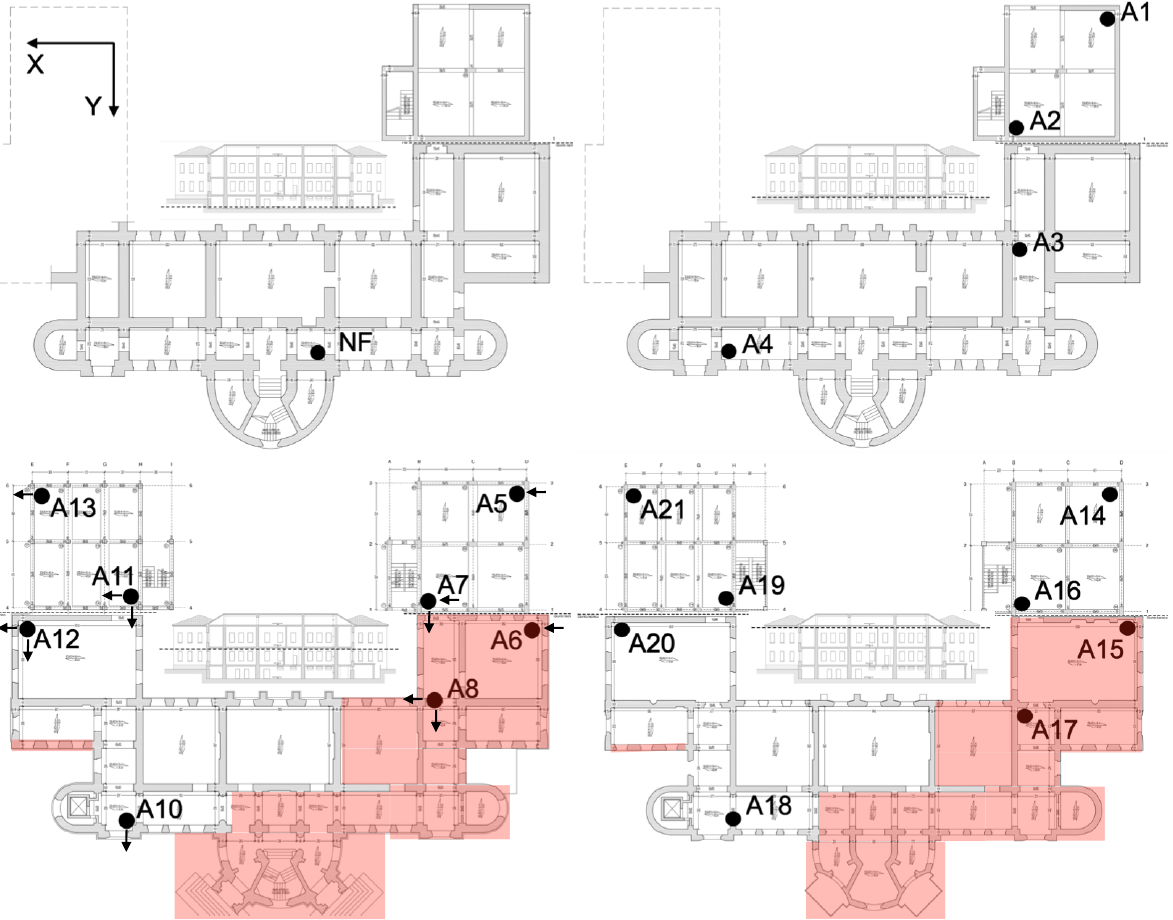
Figure 4. Location of the sensors. The corresponding elevations are reported as dashed lines in the small sections (respectively, levels 0, 1, 2 and 3); the arrows represent the recorded components that are similar on each vertical alignment. Positive directions of x - and y -axis are also reported; hatched areas correspond to collapsed elements during the 2016 earthquake. The aggregate has global dimensions of about 47 m along the x -axis and about 30 m (except the semicircular portion) along the y